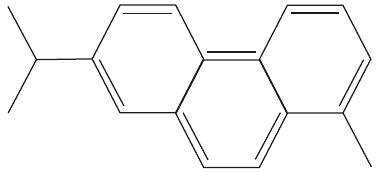
Figure 8: Structure of